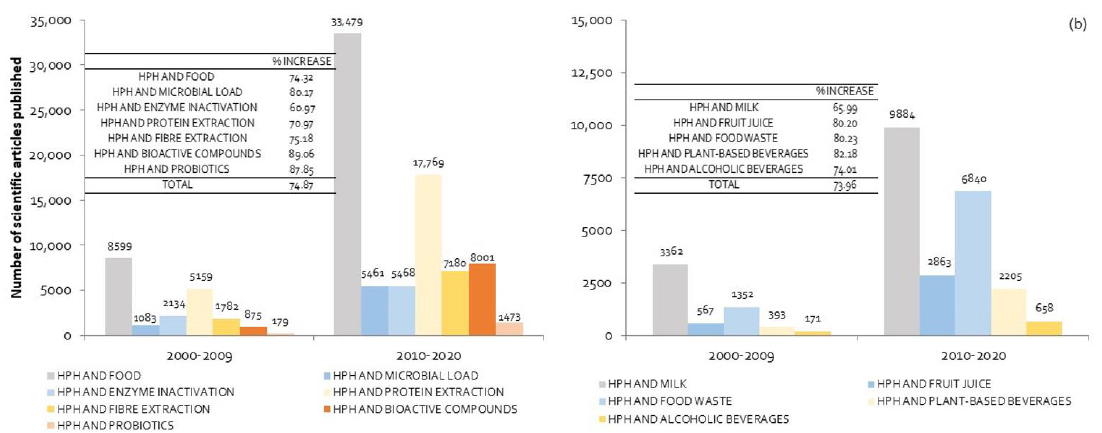
Figure 1. Number of scientific articles published according to areas of application of HPH in the food industry ( a ) and the different types of food with which it has been used ( b ). % INCREASE was calculated as the difference in the number of articles published between 2010 – 2020 and 2000 – 2009, divided by the number of articles published in the period 2000 – 2009, expressed as a percentage.